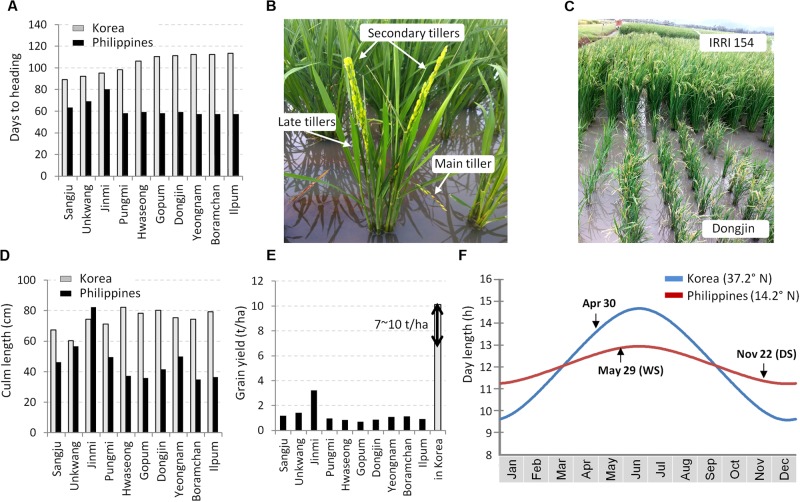
Phenotypes of the temperate japonica varieties in the tropical region. Ten Korean temperate japonica varieties were tested in the dry season in Los Baños (14.2° N), Philippines and in Suwon (37.2° N), Korea. (A) Comparison of days to heading (DTH). (B) Irregular flowering among tillers (Dongjin variety). (C) Photo of the maturation stage. (D) Comparison of culm length. (E) Comparison of grain yield. Yield data in Korea were obtained from the rice variety information released by the RDA. (F) Seasonal day-length (h) of the RDA Suwon station and the IRRI headquarter in Los Baños. The dates of seeding are depicted in the graph. DS, dry season; WS, wet season.